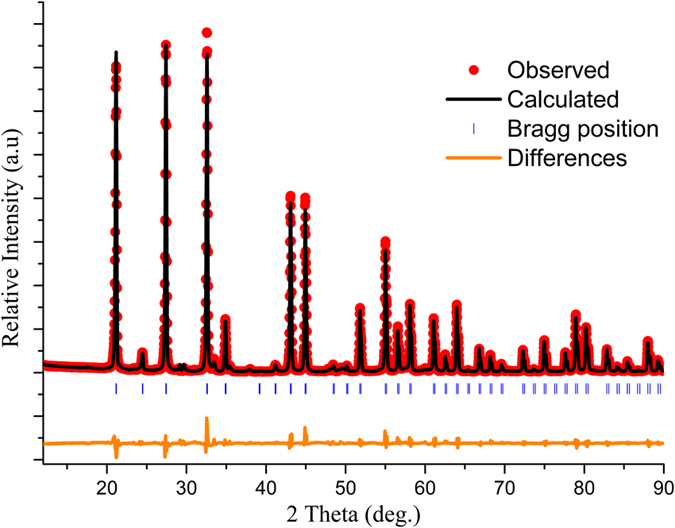
Rietveld refinement of the Bi4Si3O12: 2 at% Eu3+ phosphor.